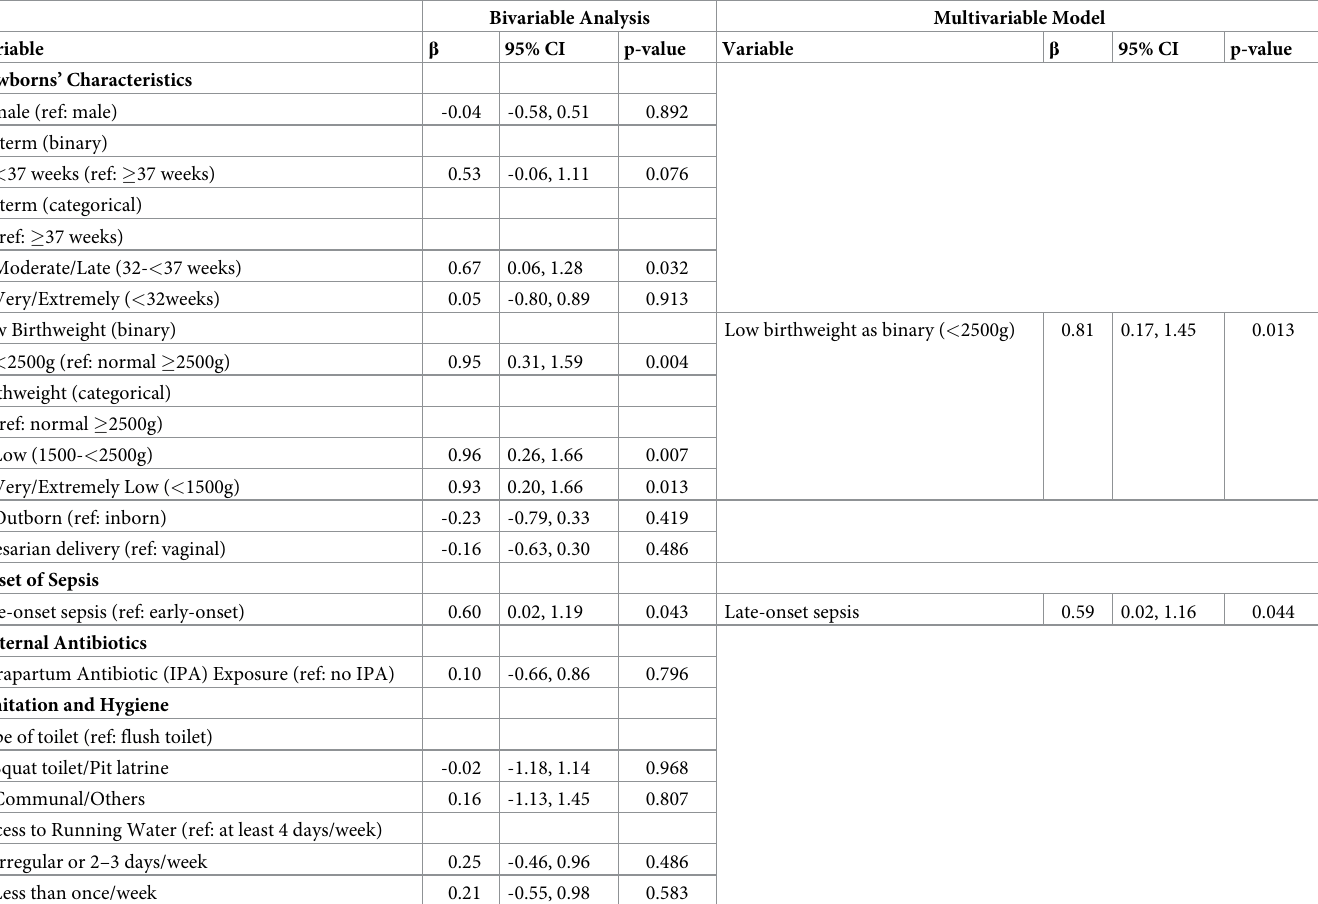
Table 3. Neonatal, maternal, and environmental factors associated with multidrug resistance (MDR score of 0–9) among 119 newborns with gram-negative